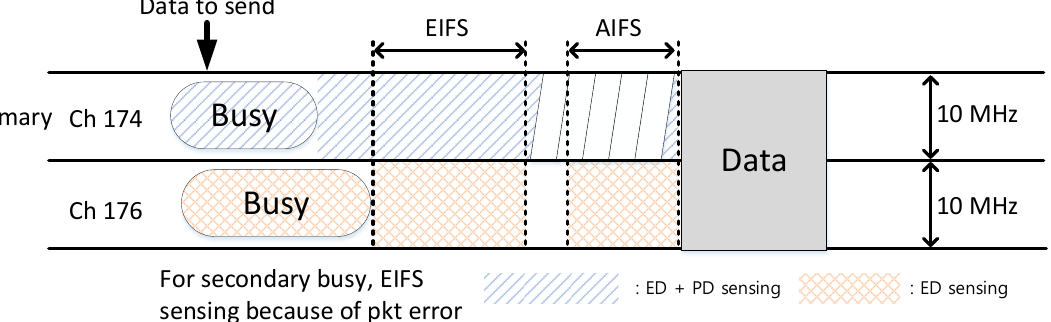
Figure 6. Access variant scheme for 20-MHz channel with modification of conventional wideband channel access scheme.